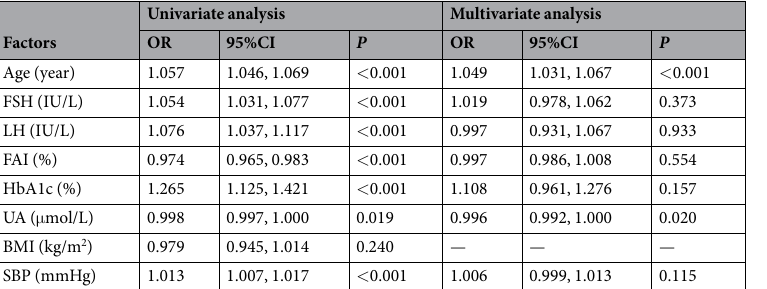
Table 3. Influential factors for ED Binary logistic regression was used to examine the influential factors for ED. Abbreviations: FSH, follicle-stimulating hormone; LH, luteinizing hormone; SHBG, sex hormone binding globin; FAI, free androgen index; HbA1c, glycated hemoglobin; UA, uric acid; BMI, body mass index; SBP, systolic blood pressure; ED, erectile dysfunction; OR, odds ratio; CI, confidence